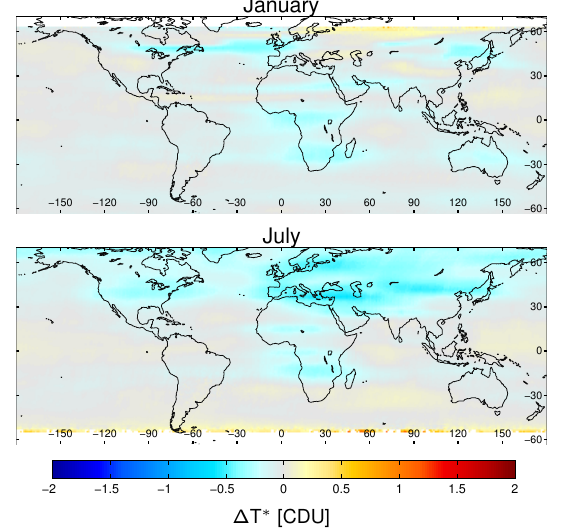
Figure 13. Monthly mean difference of tropospheric residues T ∗ from GDP 4.7 and STREAM for GOME-2 measurements in January (top) and July (bottom) 2010.